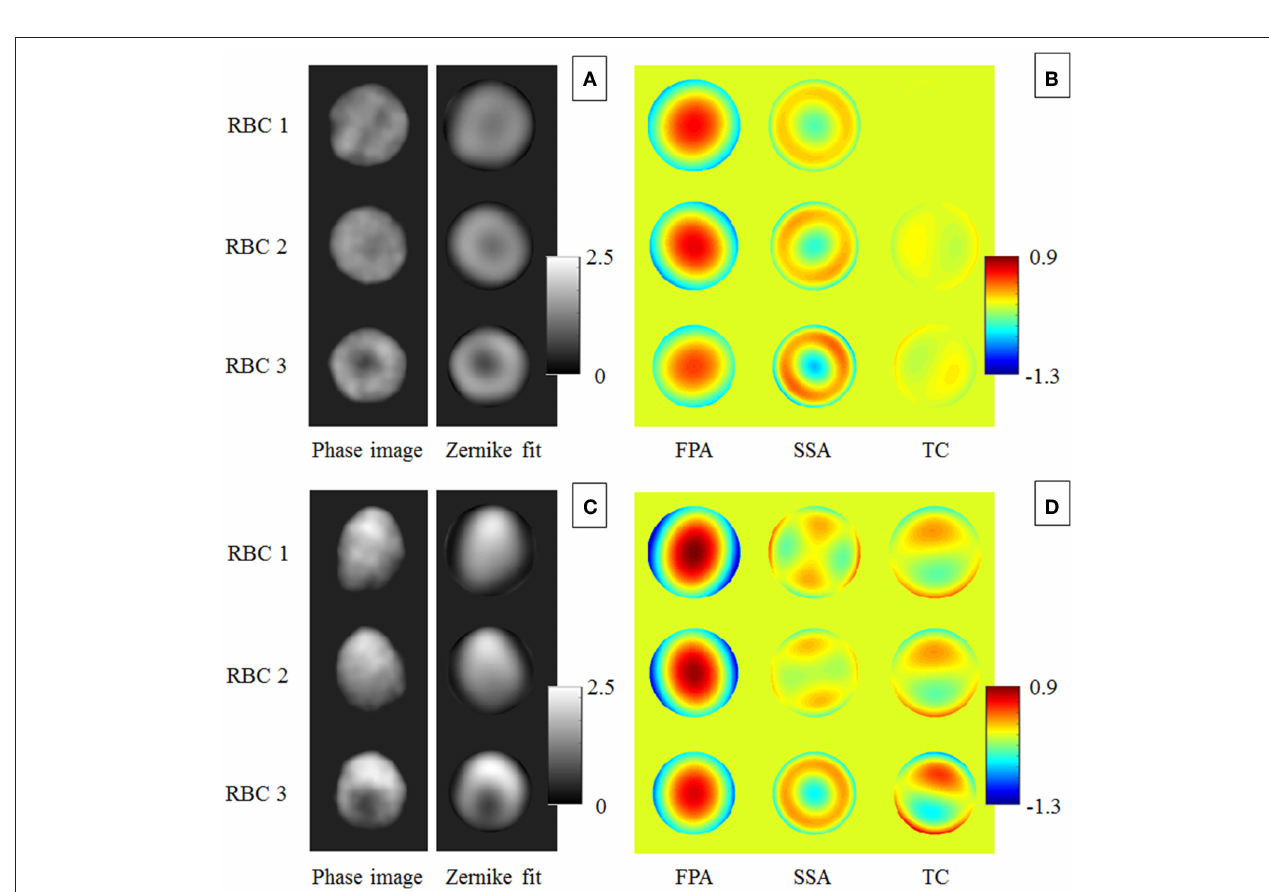
FIGURE 5 | Bio-lensing metrics used to monitor the biomechanical deformation of RBCs. (A,C) report three RBCs, namely RBC1, RBC 2, and RBC 3 and the corresponding Zernike polynomials fitting before and after applying the hydrodynamic stress, respectively. In (B,D) the measured aberration contributions, namely FPA, SSA and TC are